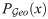
Histogram of probability PGeo(x) for sequences x with |x| = 8.